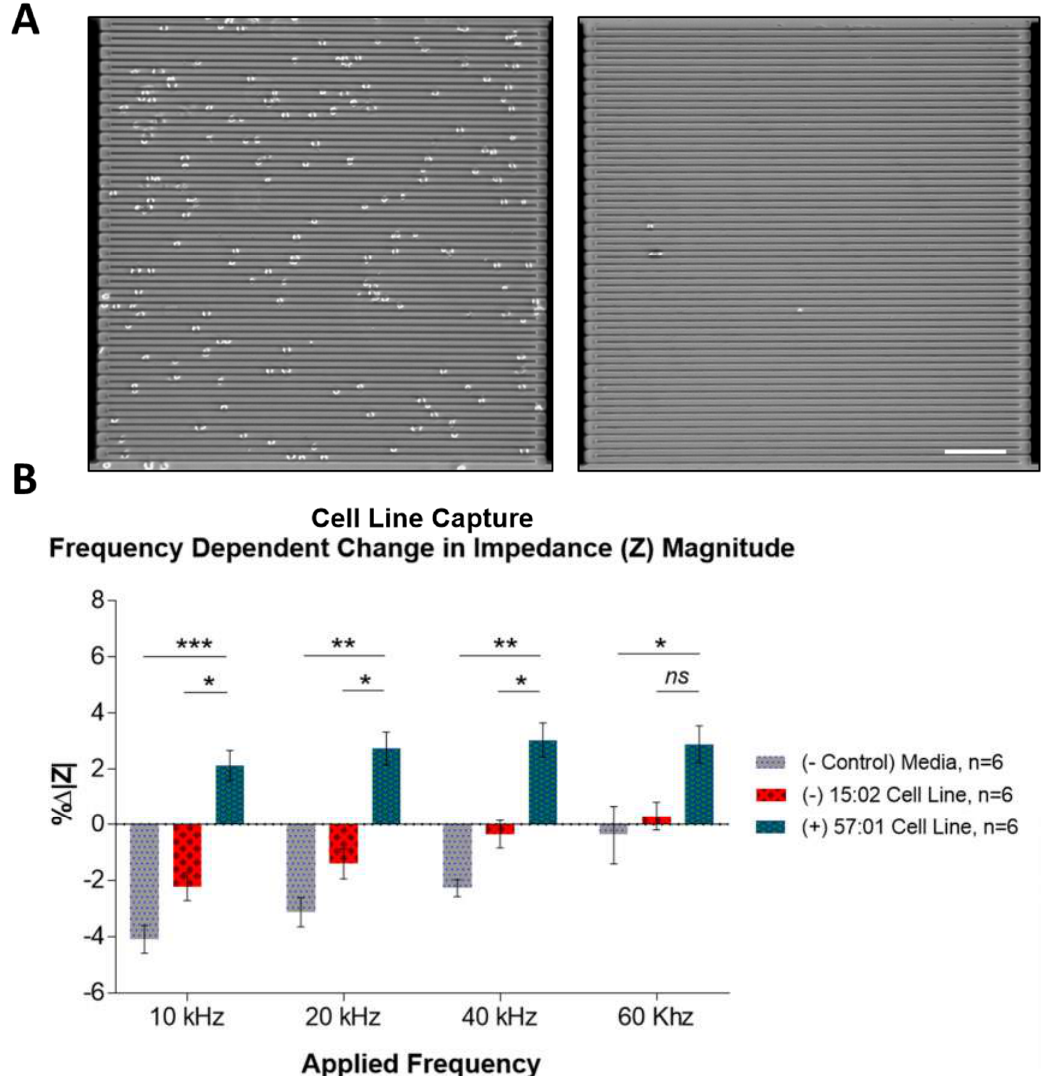
Figure 4. Interdigitated electrode (IDE) sensors detecting sensors with captured HLA-B*57:01 expressing cell line. ( A ) Micrograph showing HLA-B*57:01 positive cells captured on dielectric sensors functionalized with 3E12 antibody (left). Less cells were captured when HLA-B*15:02 cells were incubated on the sensor (right). ( B ) At applied frequency of 10 kHz and 20 kHz, sensors showed significant impedance difference with sensors incubated HLA-B*57:01 cells compared to HLA-B*15:02 cells and blank. (mean ± SEM. Bar = 100 μm).